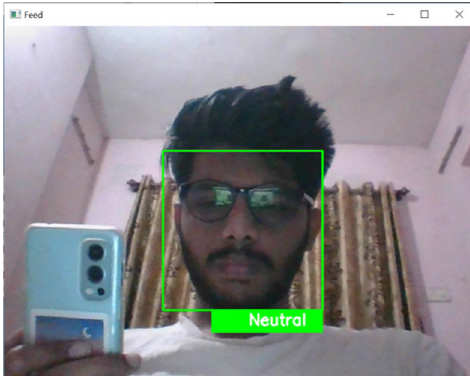
Fig. 9. Neutral feedback by customer